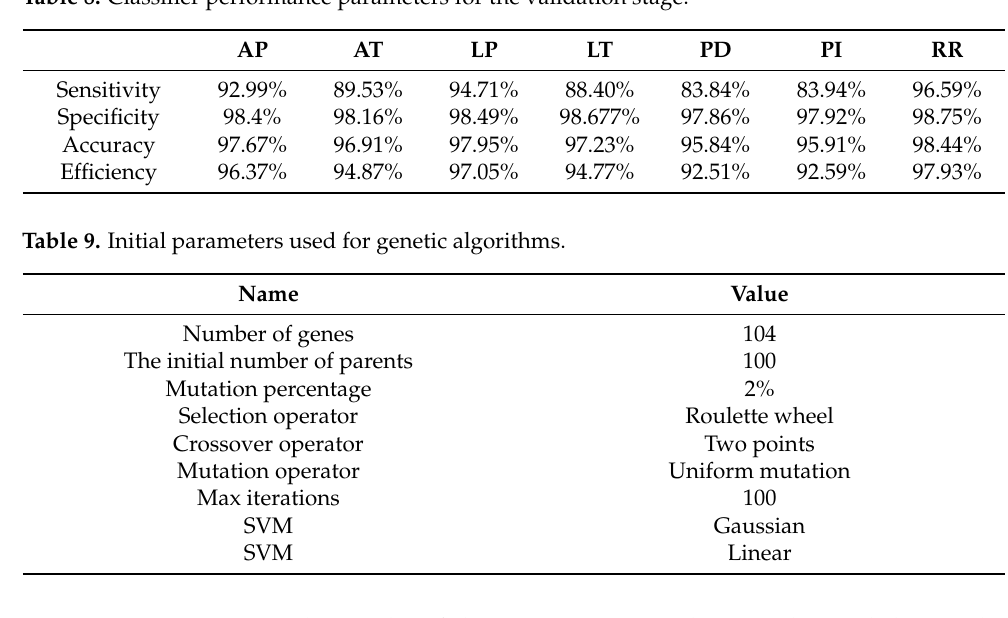
Table 8. Classifier performance parameters for the validation stage.